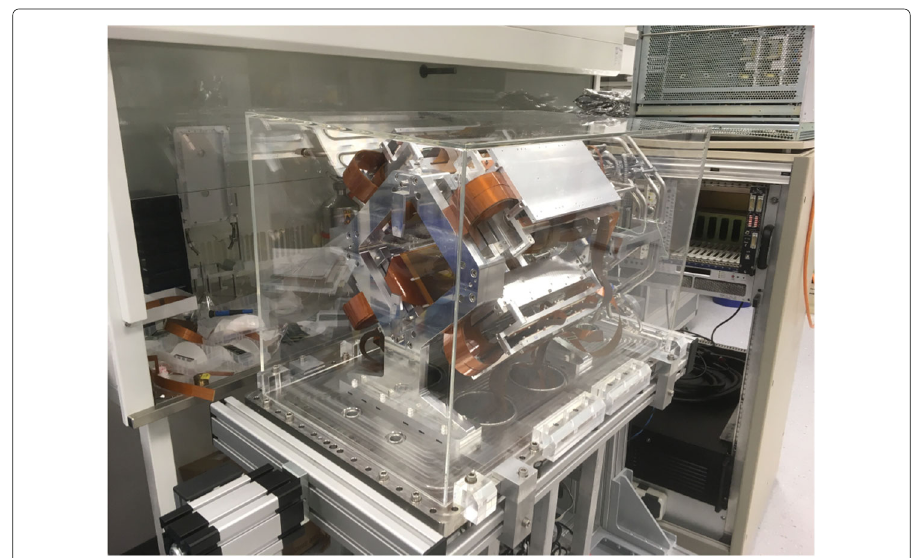
Fig. 11 Photograph of the PAX multipurpose detector